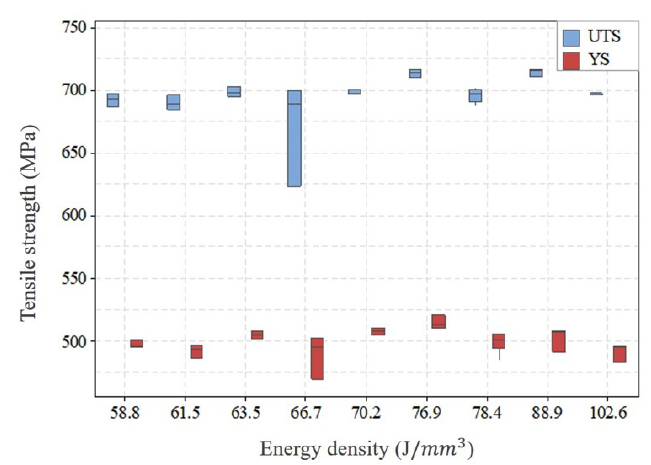
Figure 3. Tensile strength (yield strength (YS) and ultimate tensile strength (UTS)) of horizontal specimens with different parameters